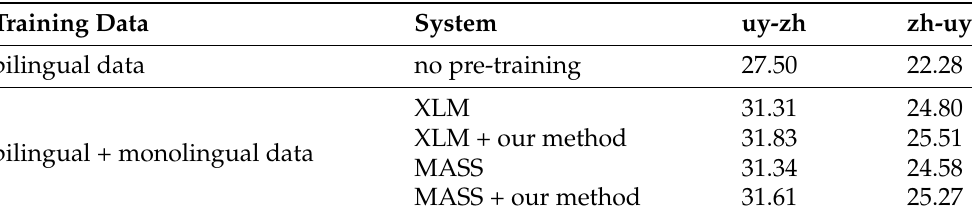
Table 2. The results of different translation systems on test sets.